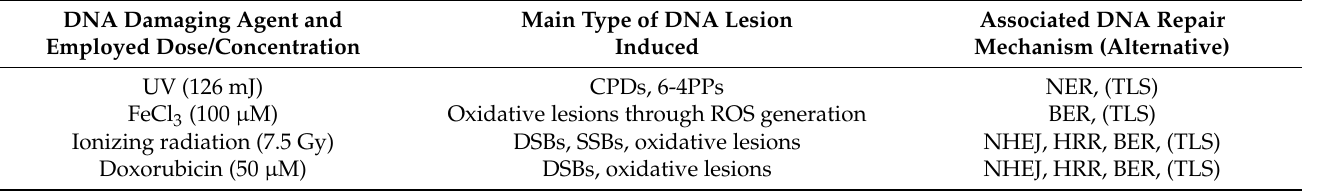
Table 1. Types of DNA lesions induced by the xenobiotic agents used and the DNA repair mechanisms that remove them. DNA Damaging Agent and Main Type of DNA Lesion Associated DNA Repair Employed Dose/Concentration Induced Mechanism (Alternative) UV (126 mJ) CPDs, 6-4PPs NER, (TLS) FeCl 3 (100 µ M) Oxidative lesions through ROS generation BER, (TLS) Ionizing radiation (7.5 Gy) DSBs, SSBs, oxidative lesions NHEJ, HRR, BER, (TLS) Doxorubicin (50 µ M) DSBs, oxidative lesions NHEJ, HRR, BER, (TLS) CPD: cyclobutane–pyrimidine dimers; ROS: reactive oxygen species; DSBs: double-strand breaks; SSBs: single-strand breaks; NER: nucleotide excision repair; TLS: translesion synthesis; BER: base excision repair; NHEJ: nonhomologous end joining; HRR: homologous recombination